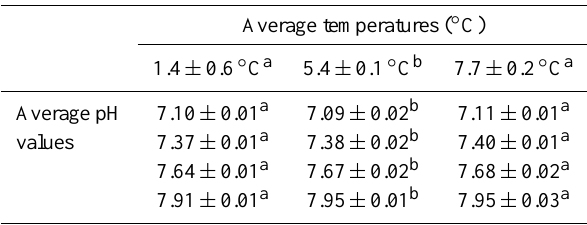
Table 2. The average temperatures ± SD ( ◦ C) and pH values ± SD in the experimental treatments from day 0 to day 7; a n = 12; b n =